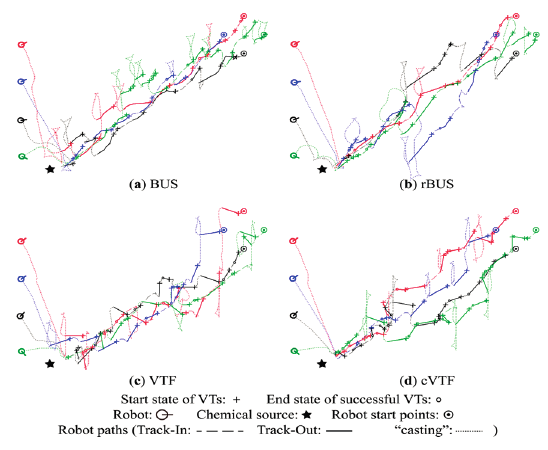
Figure 15. Typical robot trajectories obtained in N